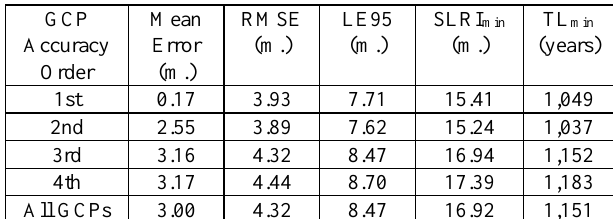
Table 6. Values of parameters related to the vertical uncertainties of the AW3D30 computed based on the order of GCP accuracy.